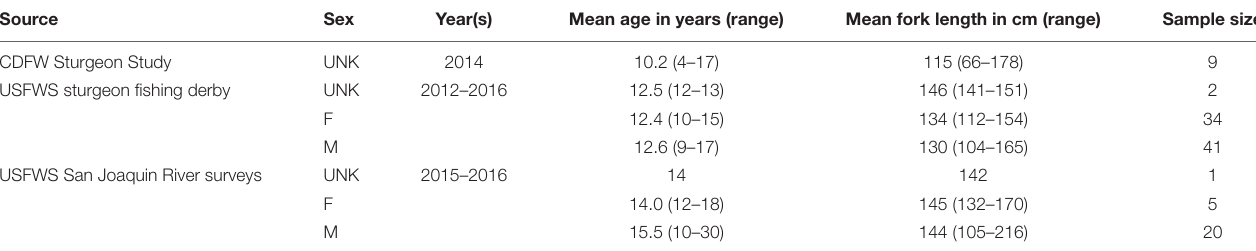
TABLE 1 | White Sturgeon fin ray sample sources, including sample size, years collected, mean and range of fish age and fork length (cm), and sex. Source Sex Year(s) Mean age in years (range)